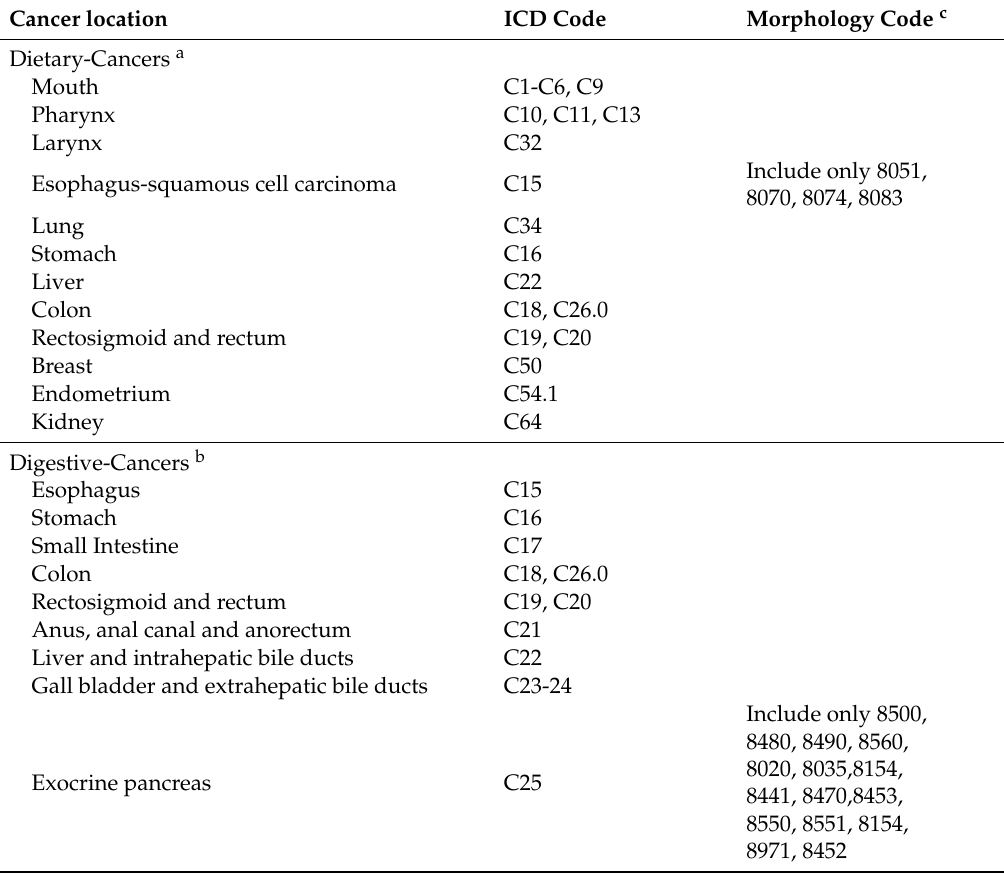
Table 1. Summary of primary cancers used in subgroup survival